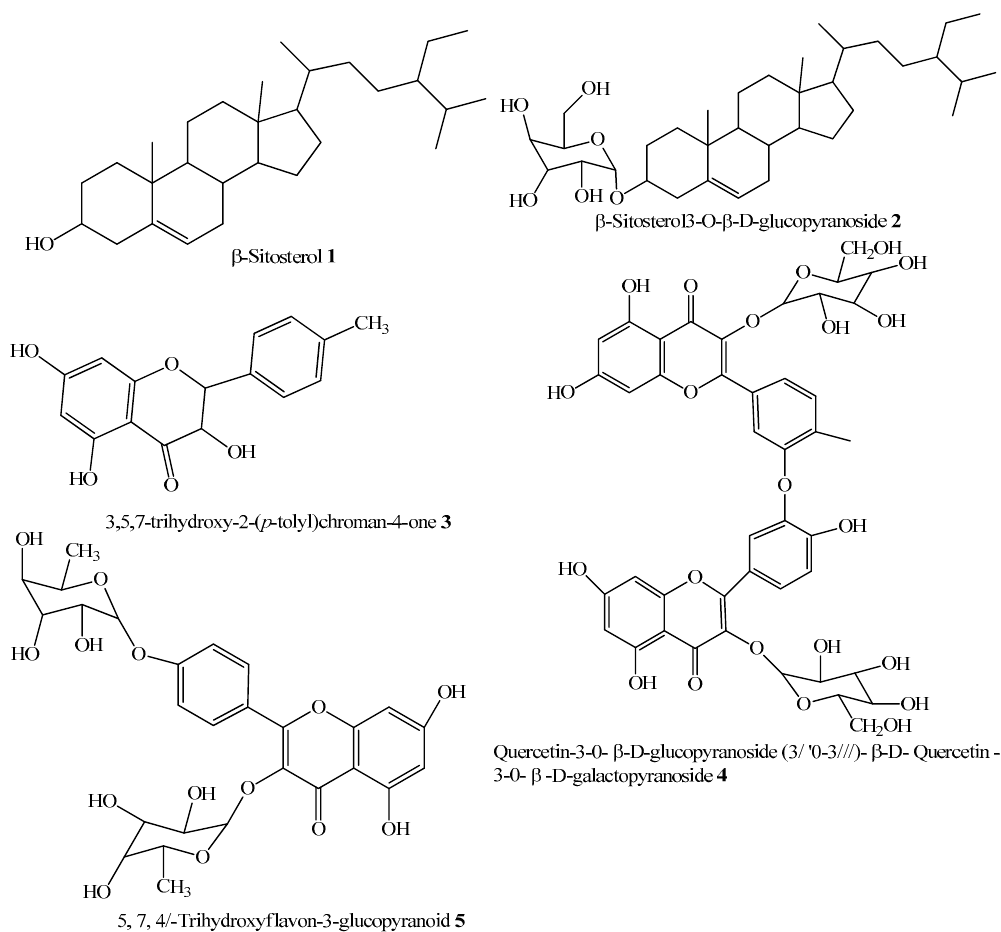
Figure 1. Structure of test compounds 1–5 isolated from Dryopteris cycadina . Table 1. Half-maximal inhibitory concentrations of test compounds ( 1–5 ) isolated from Dryopteris cycadina.